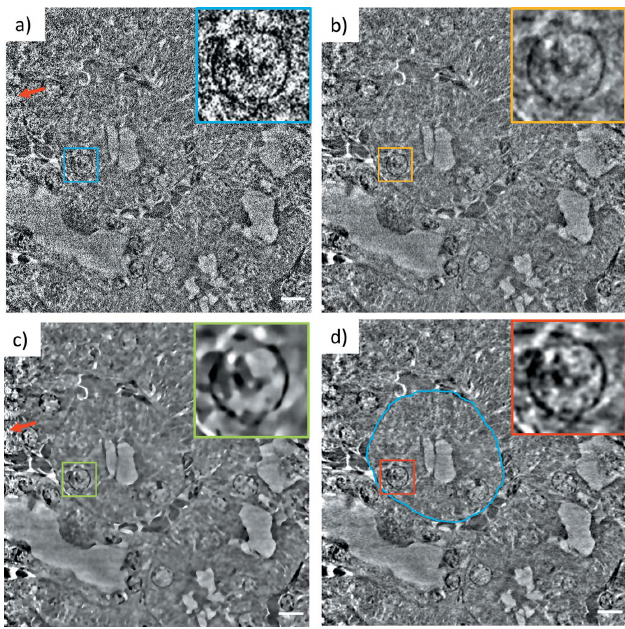
Figure 7 ROI tomography of a mouse kidney in a yz view for ( a ) the unfiltered reconstruction, ( b ) the median 3D filter, ( c ) the NLM filter and ( d ) ML applied. The insets show the magnified nucleus of a cell. The blue outline shows a kidney tubular structure. Noise increases at the edges of the image, as indicated by the red arrows. The scale bars are 5 m m.